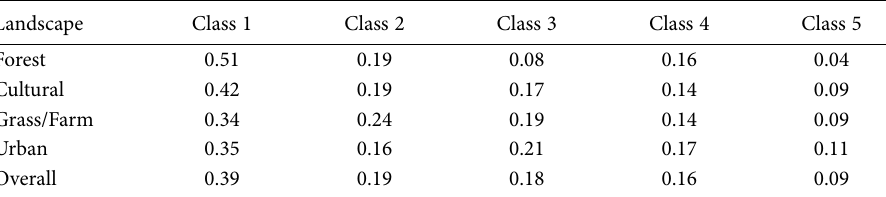
Table 7. Class probabilities by landscape